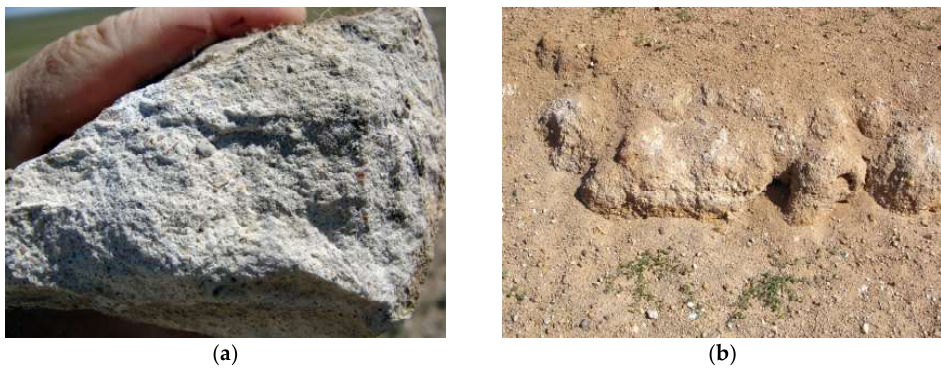
Figure 3. ( a ) Sample of the Delgerhid block, anomaly 2426/271; ( b ) sample of the Sainshand block, from Soviet excavation, anomaly 2426/262.